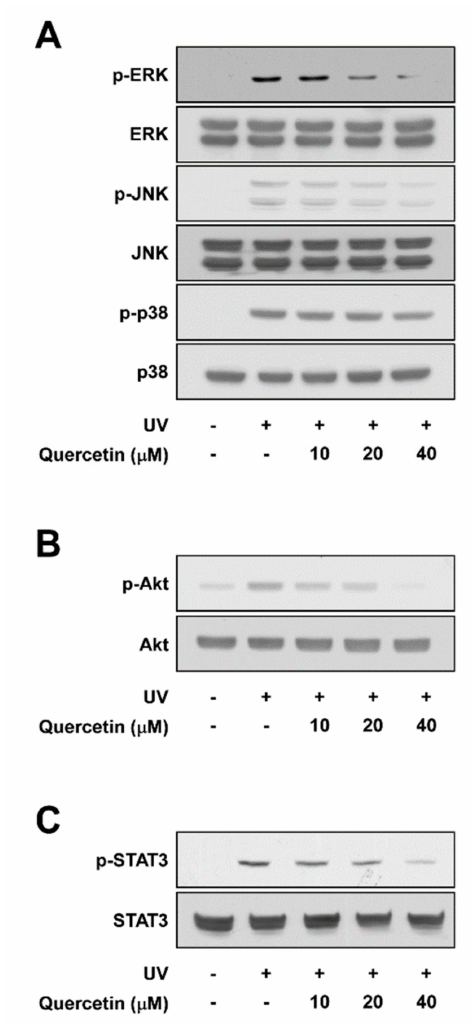
Figure 3. E ff ect of quercetin on UV-induced signaling pathways. Cells were pre-treated with quercetin at the indicated concentrations for 1 h, before exposure to UV irradiation. Protein levels of phosphorylated and total ( A ) ERK, JNK, p38; ( B ) Akt; and ( C ) STAT3 were assessed in cell lysates by immonoblot. Immunoblots are representative images of three independent